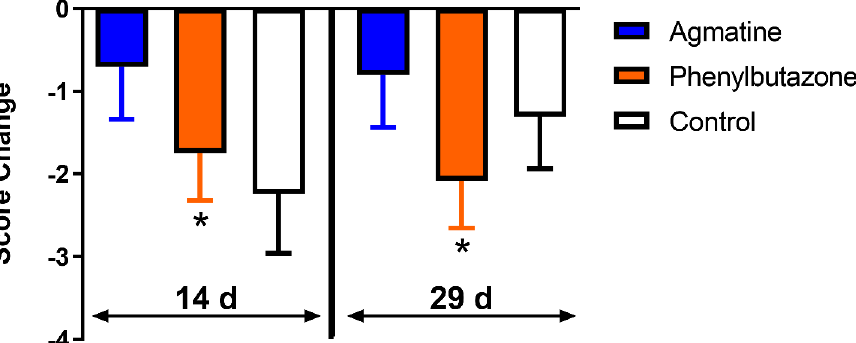
Figure 3. Changes in subjective AAEP Lameness Score (LS mean ± SEM). The AAEP lameness score changes after 14 (14 d) and 29 (29 d) days of oral agmatine (blue), phenylbutazone (orange) or control (white) administration relative to the baseline. Individual thoracic limb scores were combined to give a single score for each horse at all time points. Asterisks indicate a significant change ( p < 0.05) from the baseline. Table 4. Changes in subjective AAEP Lameness Score. Min: minimum; Max: maximum; KS: p -value of Kolmogorov – Smirnov test.